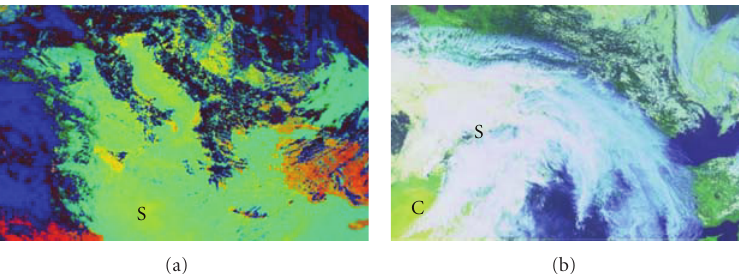
Figure 13: NOAA AVHRR images coloured versions (a) of channels 4, 5, and 4 inverted at 14:17 UTC on 2 April 1988 and (b) of channel 4 at 14:17 UTC on 3 April 1988.